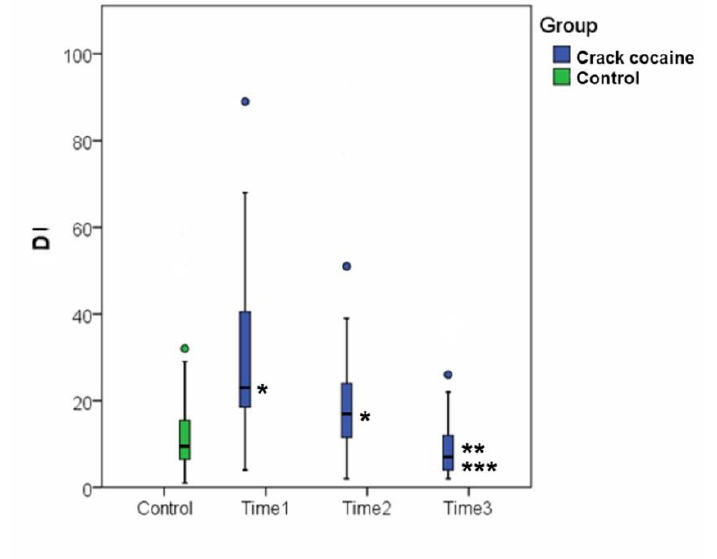
Figure 2. Damage index at each of the three time points of assessment and comparison with the control group; ● outliers: values that lie more than one and a half times the length of the box from the end of the box; statistically significant differences: * versus the control group; ** versus Time Point 1; *** versus Time Point 2. Time 1: beginning of withdrawal; Time 2: 48 h after withdrawal; Time 3: at the end of the treatment period (21 to 30 days after